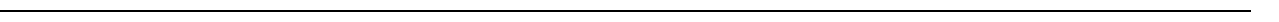
Fig. 4 RNF4 limits SUMO signaling by targeting SUMO E3s for degradation. a Scatter plot showing RNF4-TULIP target proteins that are enriched upon MG132 treatment in a SIM-dependent manner and also found to be SUMO targets enriched upon RNF4-knockdown. Purple dots represent SUMO E3 ligases. b PIAS1 is a SIM-dependent RNF4 substrate targeted to the proteasome for degradation. Stable U2OS cell lines expressing the different RNF4- TULIP constructs were generated and the expression of the constructs was induced with doxycycline. RNF4-TULIP conjugates were puri fi ed from the indicated cell lines after MG132 or DMSO treatment and analyzed by immunoblotting using PIAS1 antibody. c U2OS cells stably expressing His10-SUMO2 were separately infected with lentiviruses expressing three different shRNAs directed against RNF4 or a control shRNA. Three days post-infection, the cells were harvested, and His10-SUMO2 conjugates were puri fi ed from denaturing lysates and analyzed by immunoblotting against PIAS1. d The overall increase in protein SUMOylation upon RNF4-knockdown is counteracted by co-knockdown of PIAS1. U2OS cells were (co)-infected with lentiviruses expressing shRNAs against RNF4, PIAS1, or PIAS4 or a control shRNA as indicated. Three days after infection, the cells were lysed in a denaturing buffer and knockdown ef fi ciencies and overall levels of SUMO2/3 were analyzed by immunoblotting. The results were independently con fi rmed using a second set of shRNAs. The experiment described was independently performed three times and quanti fi ed. Averages and standard deviations of SUMO2/3 conjugate levels are depicted. e RNF4 regulates PIAS1 ubiquitylation. U2OS cells stably expressing His10-ubiquitin were infected with lentiviruses expressing shRNAs directed against RNF4 or a control shRNA. Three days after infection, the cells were lysed in a denaturing buffer and His10-ubiquitin conjugates were puri fi ed. The levels of ubiquitylated PIAS1 were veri fi ed by immunoblotting. Similarly, RNF4-knockdown ef fi ciency was veri fi ed by immunoblotting. The experiment was independently repeated and consistent results were obtained. Unprocessed full-size scans of blots are provided in Supplementary Fig.